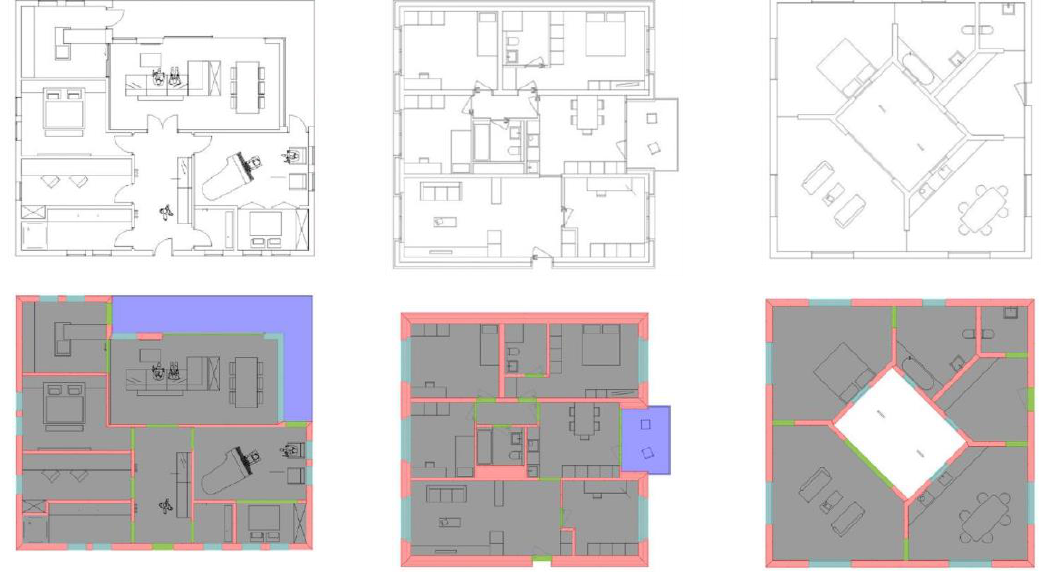
Figure 18. Three examples of floor plans for extracting architectural components that were used for the evaluation. The top row shows the input floor plan. The second row shows the color-coded objects.